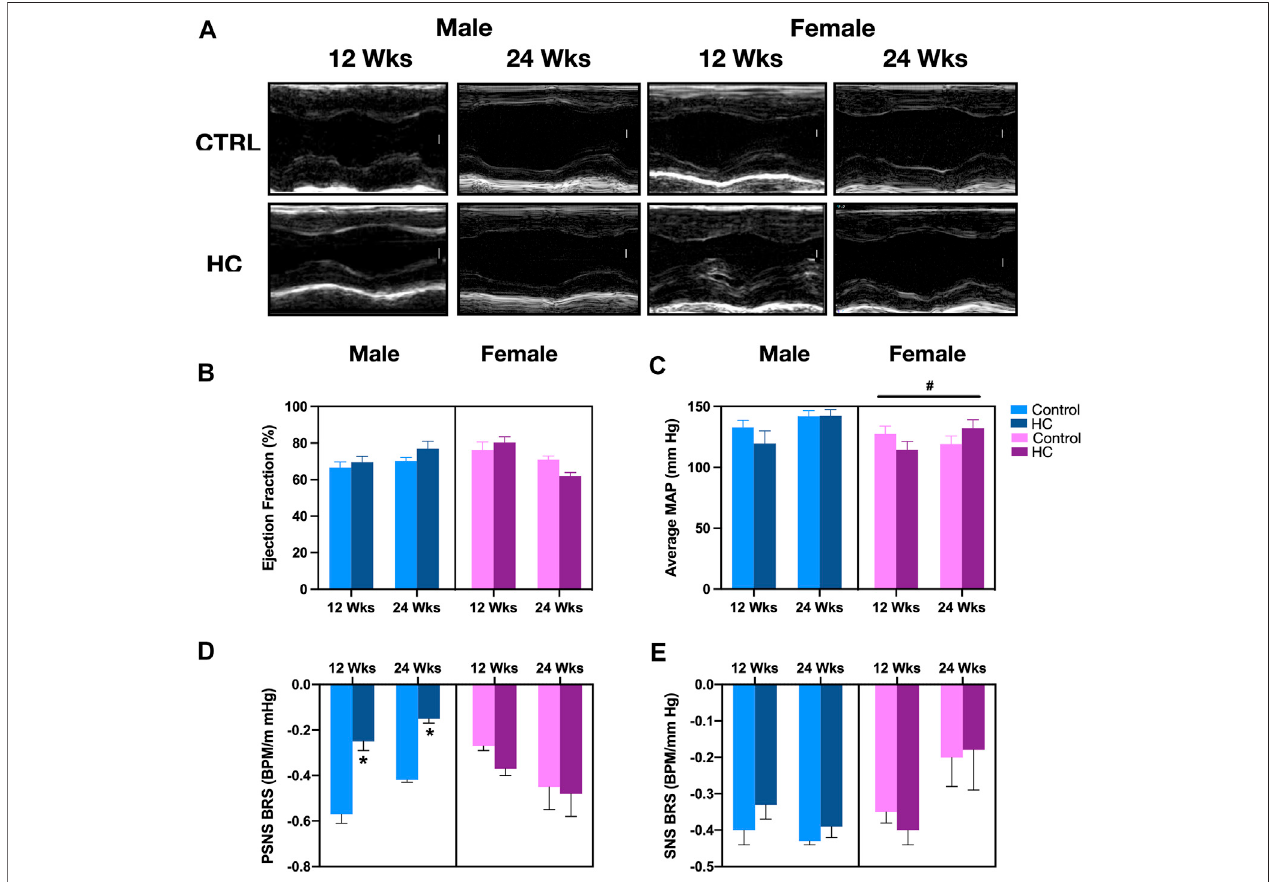
FIGURE 2 | Gross myocardial, hemodynamic, and cardiac autonomic functions in response to HC-feeding as a function of feeding duration and sex. (A) Representative electrocardiograms of M-mode images (scale bar corresponds to 1 mm), (B) ejection fraction (EF) assessed by echocardiography, (C) average mean arterial pressure (MAP) assessed by invasive carotid artery catheterization, and slope of the best- fi t linear regression of re fl ex bradycardic responses to a rise in mean arterial pressure (MAP) following increasing doses of phenylephrine (PE) or sodium nitroprusside (SNP) re fl ecting (D) parasympathetic nervous system (PSNS) or (E) sympathetic nervous system (SNS) activity, respectively, of control and hypercaloric diet (HC)-fed rats of either sex in different feeding duration groups. Statistical analysiswasperformed bythree-way ANOVA followed bySidak ’ smultiplecomparison test. *denotes a p < 0.05 vs.controlofthesame sexand feedingduration group (control vs. HC), while # denotes a p < 0.05 vs. the corresponding male group (males vs. females).